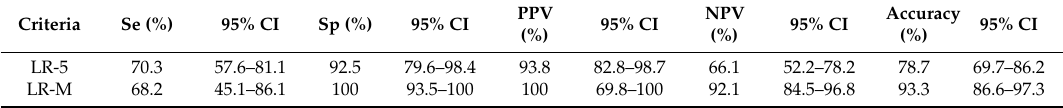
Table 6. Diagnostic performance of the modified CEUS LI-RADS LR-5 and LR-M categories.